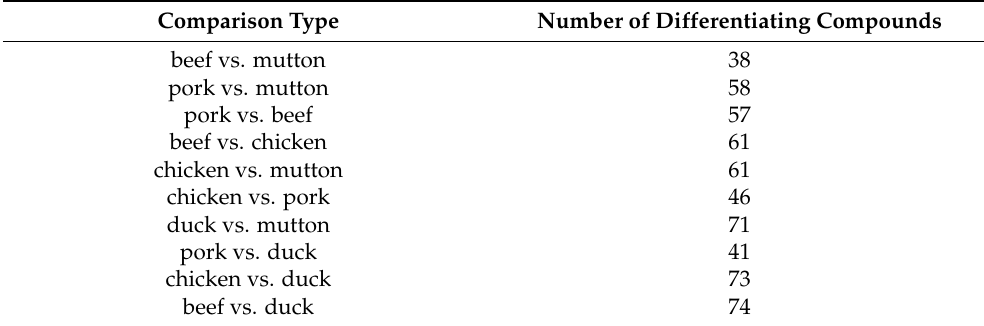
Table 2. Overview of the differentiating compounds, from volcano plot analysis with p < 0.05 and fold change ≥ 2.